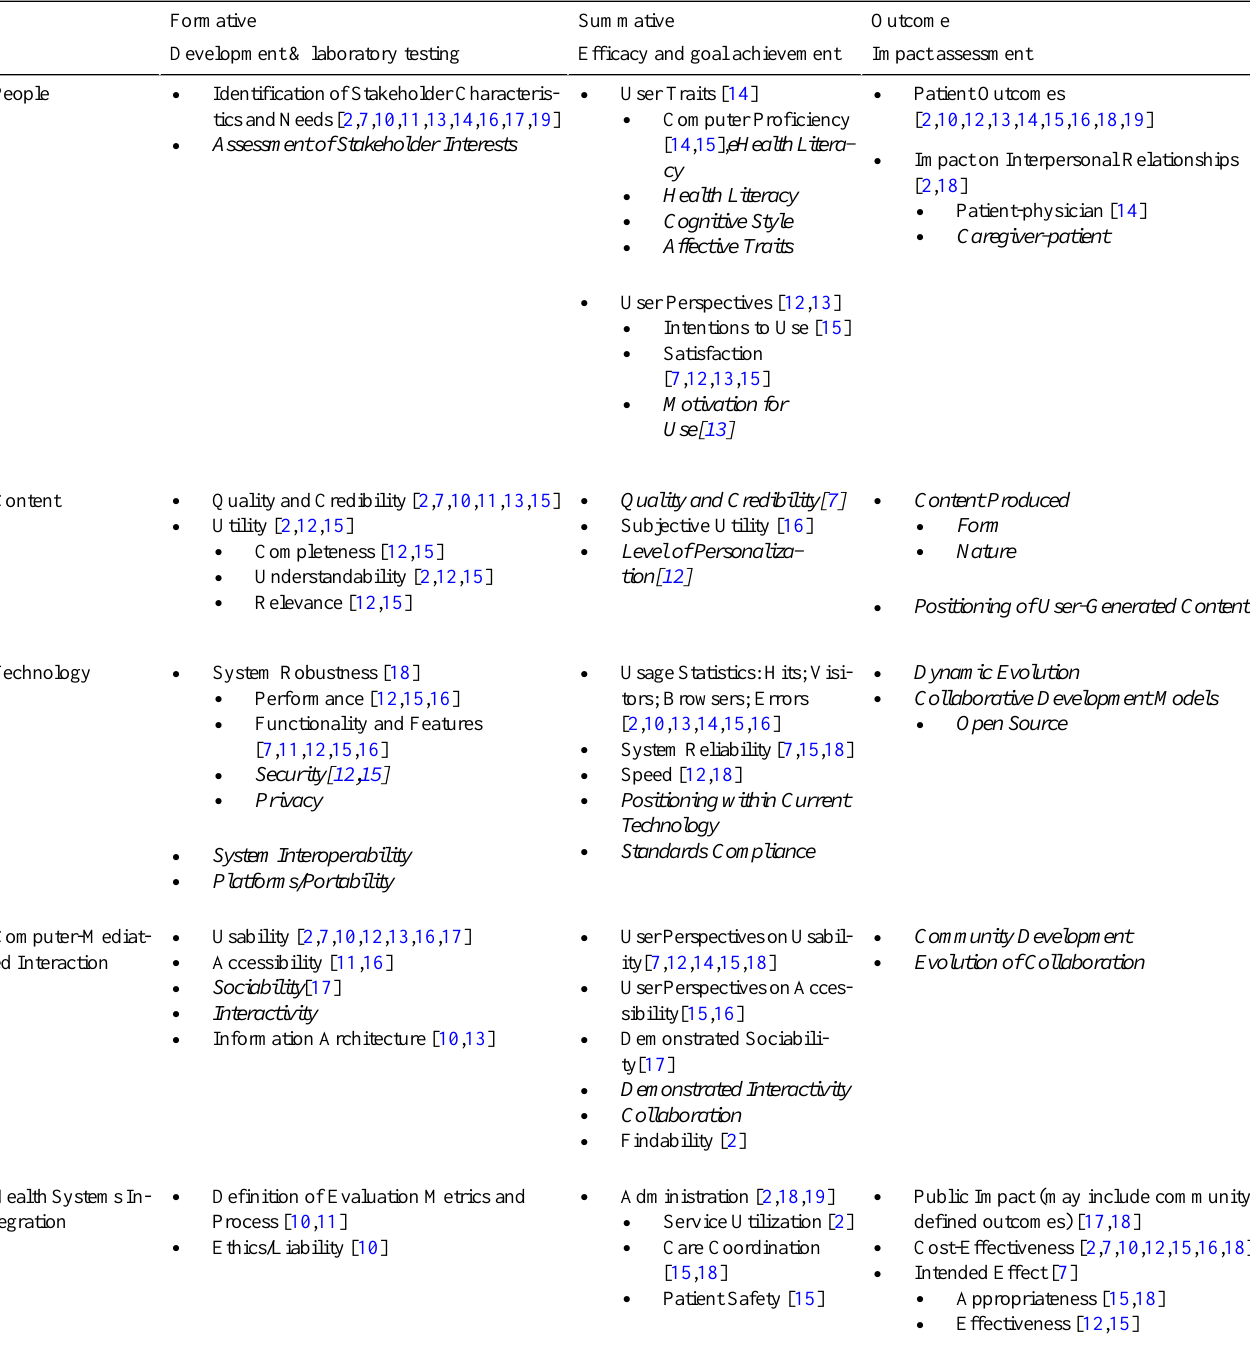
Table 1. Evaluation schema: collaborative, adaptive and interactive technology. Elements which were not identified in the authors' review of the literature are printed in italics